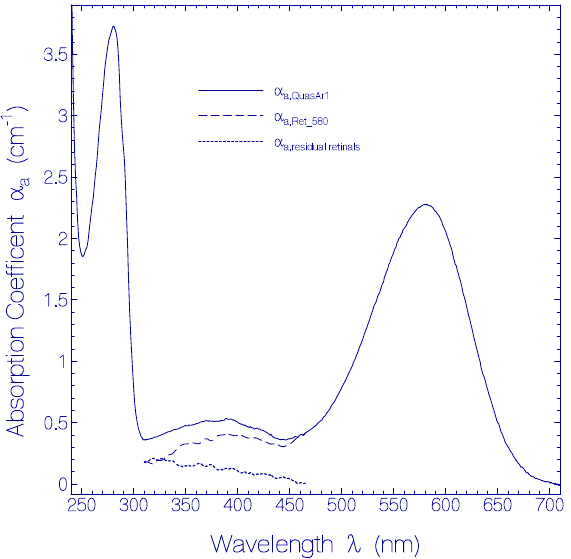
Figure 1. Absorption coefficient spectrum of a fresh thawed QuasAr1 sample in pH 8 Tris buffer. Solid curve: measured absorption coefficient spectrum α a,QuasAr1 ( λ ). Dashed curve: absorption coefficient spetrum α a,Ret_580 ( λ ) of PRSB Ret_580. Dotted curve: absorption coefficient spectrum of residual retinal components α a,residual retinals ( λ ) = α a,QuasAr1 ( λ ) − α a,Ret_580 ( λ ).